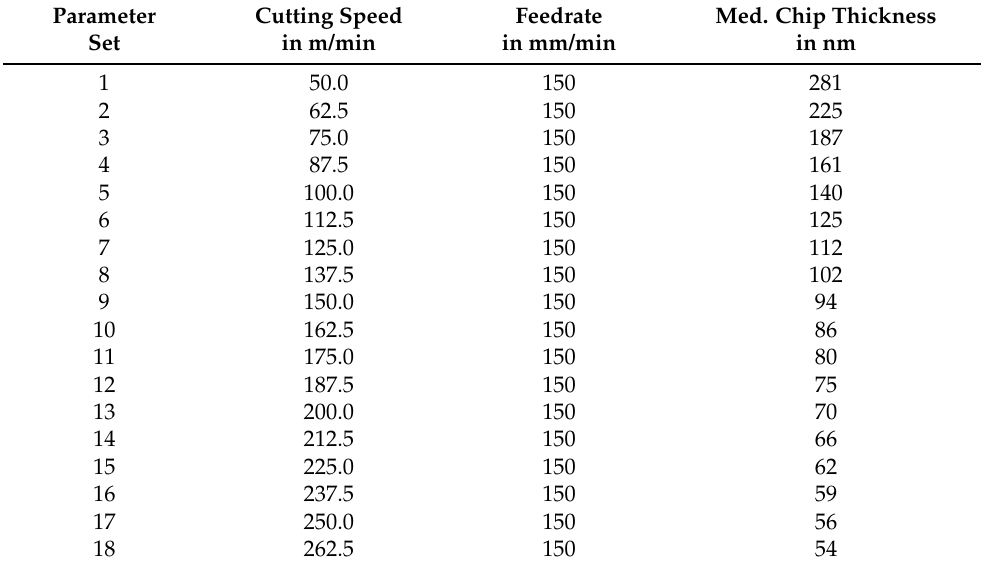
Table 2. Overview of the first experiment